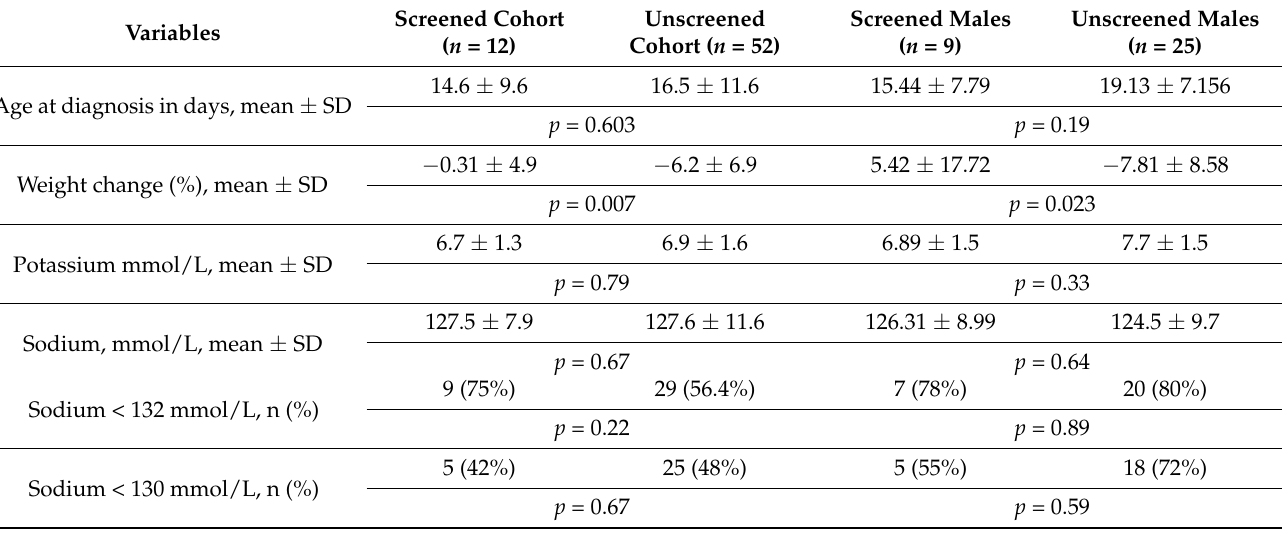
Table 3. Age at diagnosis, weight change, and biochemical profile is screened and unscreened infants with SW CAH.